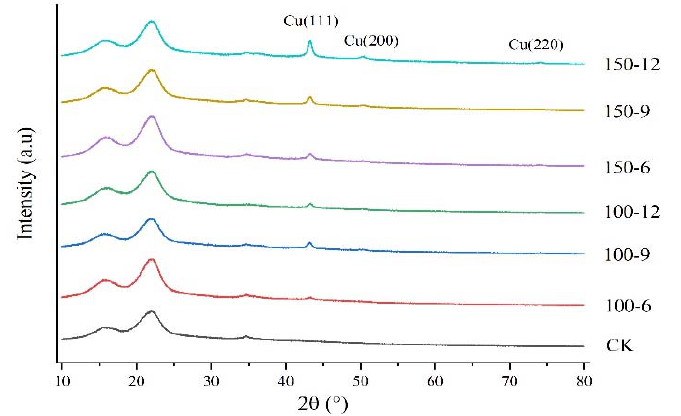
Figure 4. XRD patterns of the bamboo fiber bundle and samples after magnetron sputtering.